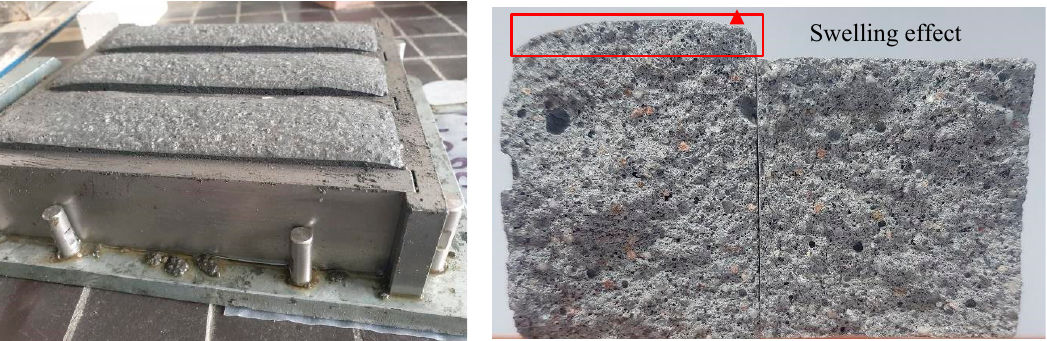
Figure 7. Swelling of the cement mortar with the addition of 18% fly ash.